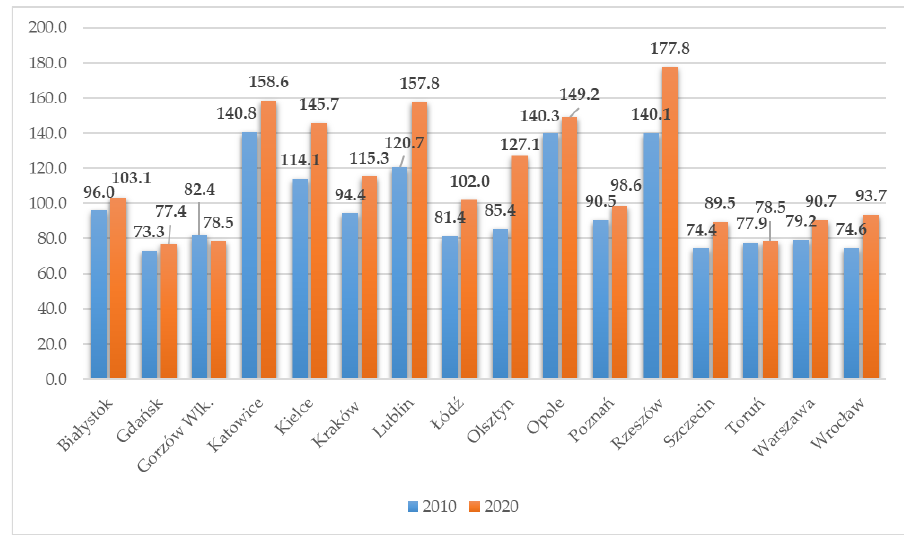
Figure 6. The number of nurses per 10,000 residents in the surveyed Polish cities in 2010 and 2020. It is worth adding, however, that in terms of the number of nurses per 10,000 residents, Poland is ranked as the penultimate country in the European Union (followed only by Greece). The average for Poland is 50 nurses per 10 thousand residents, while in highly developed countries its value significantly exceeds 100 (e.g., Norway—180; Iceland—145; Germany—129) [127]. Although all the surveyed cities are characterized by an indicator higher than the one calculated collectively for Poland, only in a few cities its value ap- proaches the one of the European leaders. This may cause problems in the future with the provision of long-term medical care, including geriatric or palliative care. In addition to the number of doctors and nurses, medical infrastructure, including the average number of hospital beds per community, is also important in assessing the quality of health care. Thus, the size of this indicator for 2010 and 2020 in the surveyed cities is shown in Figure 7.